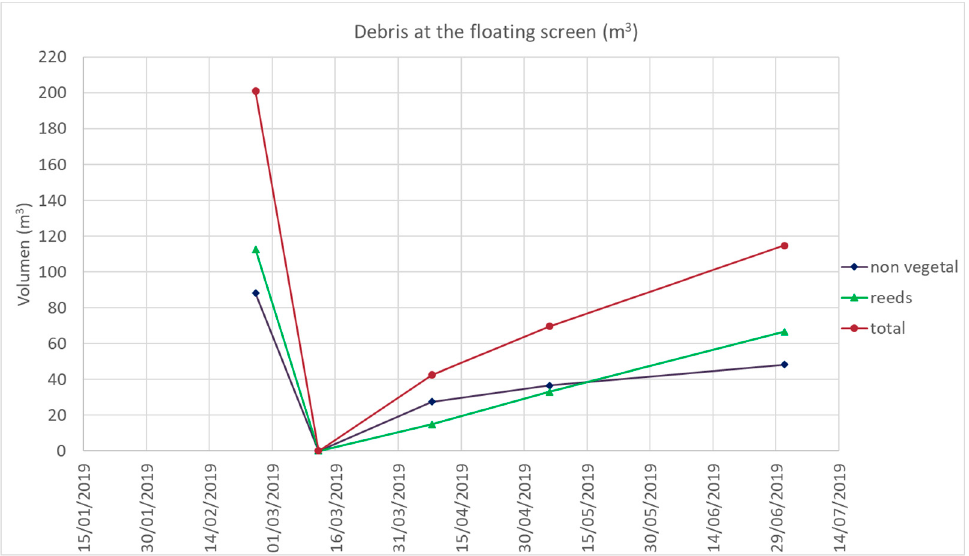
Figure 6. Estimated volume of debris at the floating screen, ID8.